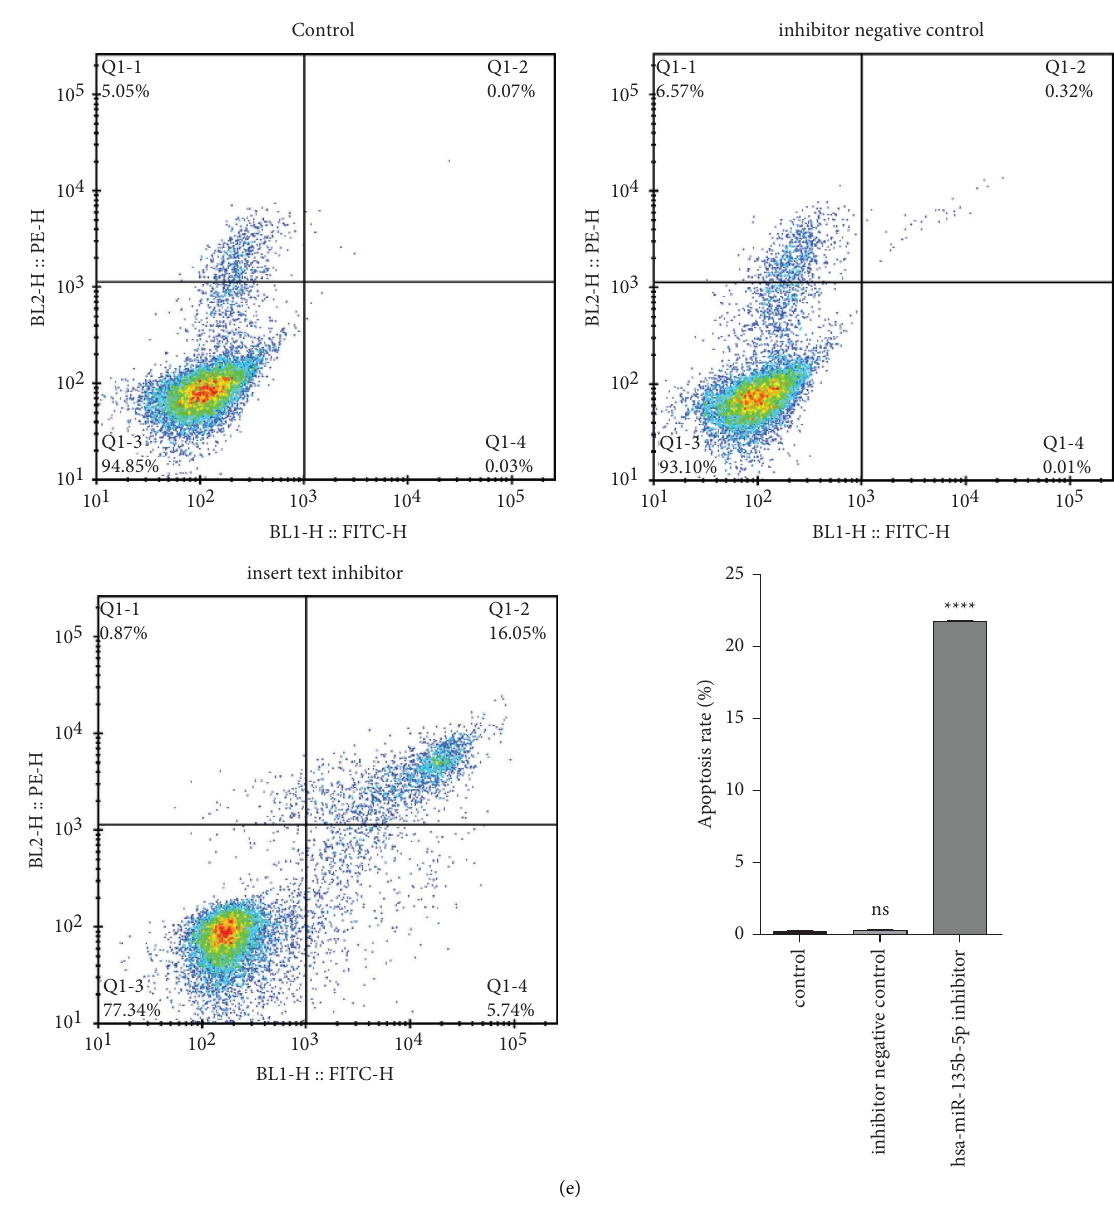
Figure 4: Efect of hsa-miR-135b-5p knockdown on COAD. (a) Relative expression levels of hsa-miR-135b-5p in COAD tissue and cell samples. (b) Transfection efciency. (c) Efect of reduced hsa-miR-135b-5p levels on SW480 cell proliferation. (d) Efect of reduced hsa-miR- 135b-5p levels on SW480 cell migration and invasion. (e) Efect of reduced hsa-miR-135b-5p levels on SW480 cell apoptosis. ∗ P < 0 . 05, ∗∗ P < 0 . 01, ∗∗∗ P < 0 . 001, ∗∗∗∗ P < 0 . 0001, and “ns” represents no signifcant